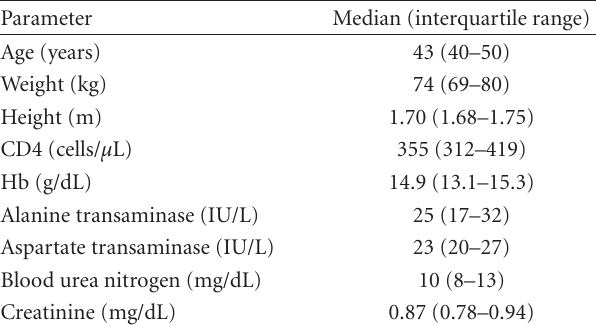
Table 1: Patient characteristics at